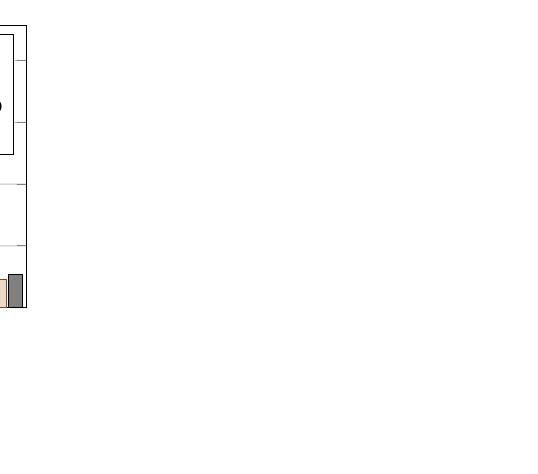
Figure 33. Power delay product of each